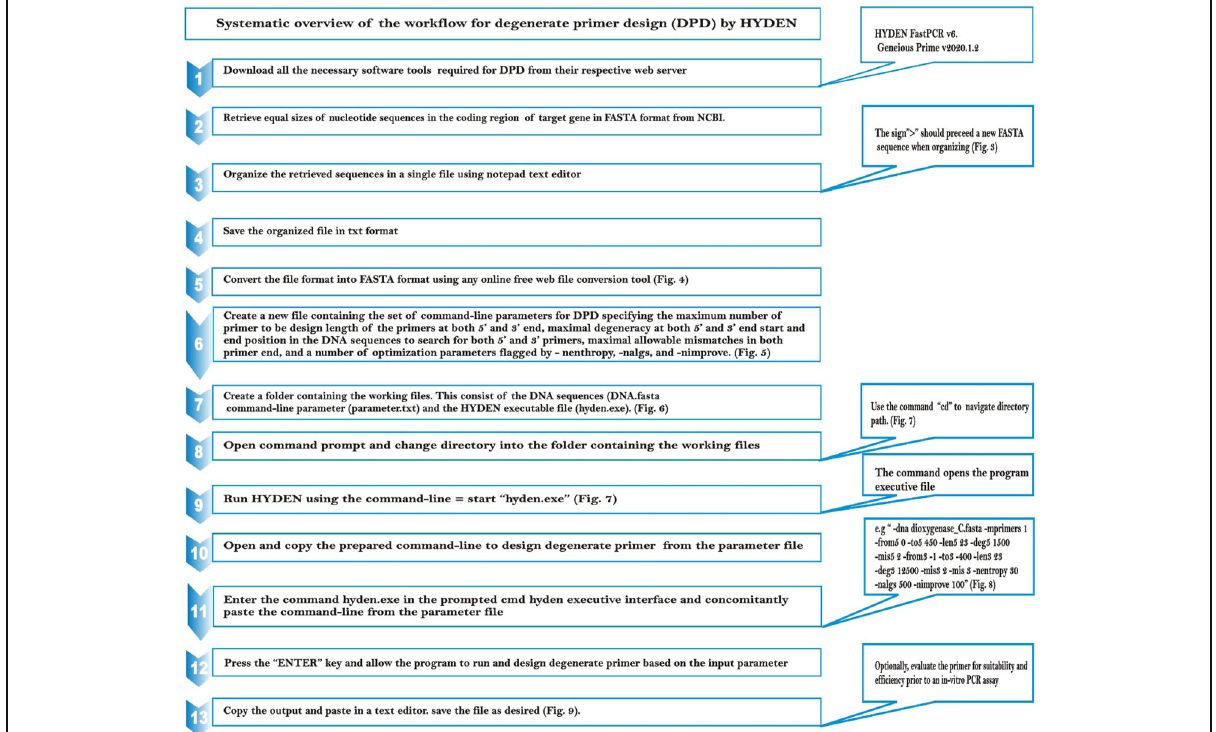
Fig. 2 Systematic overview of the workflow for designing degenerate PCR primers via HYDEN